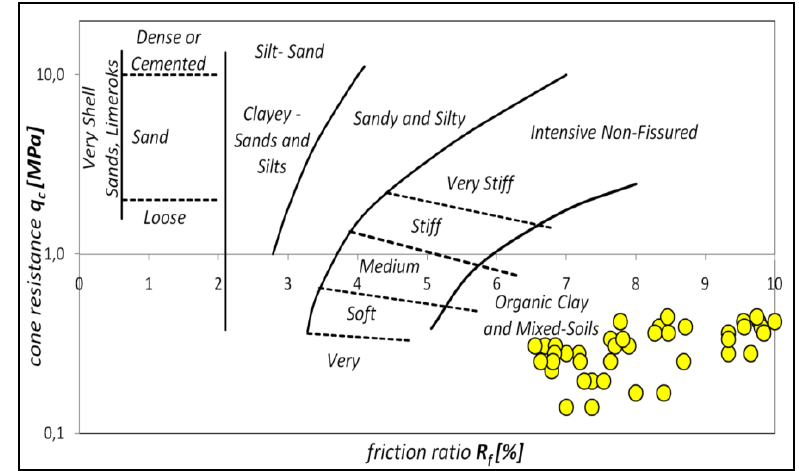
Figure 5. Diagrams present the identification of organic soils based on CPTM tests, according to the propositions of Schmertmann’s nomogram.